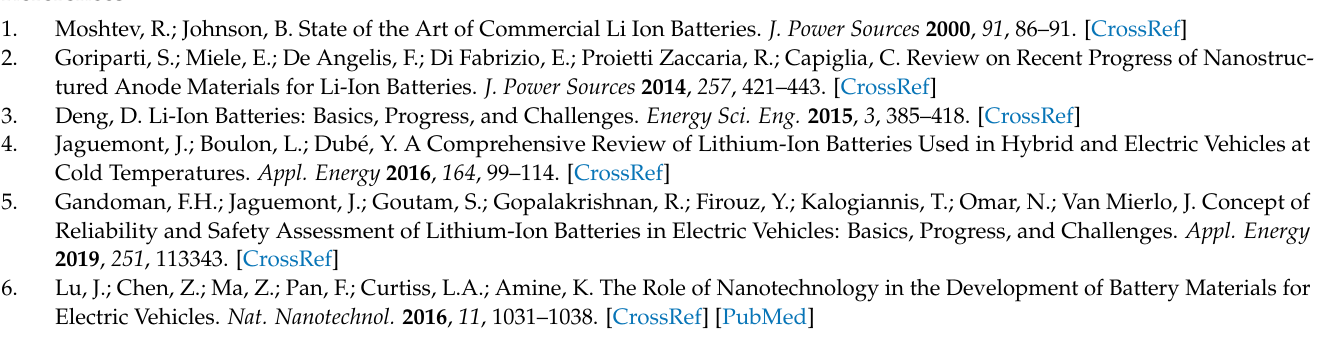
Figure S2: Particle size distributions of Si NPs (a) and Si@C NPs (b) determined from TEM im- ages. Figure S3: Raman spectra of Si@C NPs. These deconvolutions highlight the low degree of organisation of the C-shell. The detailed explanation of the various components and associated interpretations can be found elsewhere [66,67]. Figure S4: complementary XRD diffractogram of the sample references: Si, Si@C (Cu K α radiation source) and GHG (Co K α radiation source). Figure S5: Si2p HR XPS spectra of pristine Si (a) and Si@C NP samples (b), showing the low intensity of the SiO 2 contribution. Figure S6: Deconvolutions of the HR Si2p XPS spectra recorded for Si-GHG (a) and Si@C-GHG (b) after 1h of reaction. Figure S7: Coulombic efficiency of Si-GHG-18h (a) and Si@C-GHG-18h (b) during cycling. Table S1: Recapitulation of the deconvoluted Si2p components (peak position, FWHM values and atomic concentrations) attributed to Si0, SiC, Si+/Si2+, Si3+ and Si4+, along with ratios highlighting the stability of Si@C NPs-GHG composite compared to the more oxidation-sensitive Si-GHG composites (clear decrease of the Si0/SiOx with increasing reaction time). Table S2: Comparison of different electrochemical performances obtained for electrode materials containing Si or Si@C NPs and graphene as an additive (in orange) or as a 3D scaffold (in green) described in the recent literature. It is noteworthy that the frontier between graphene as 2D or 3D component is not always